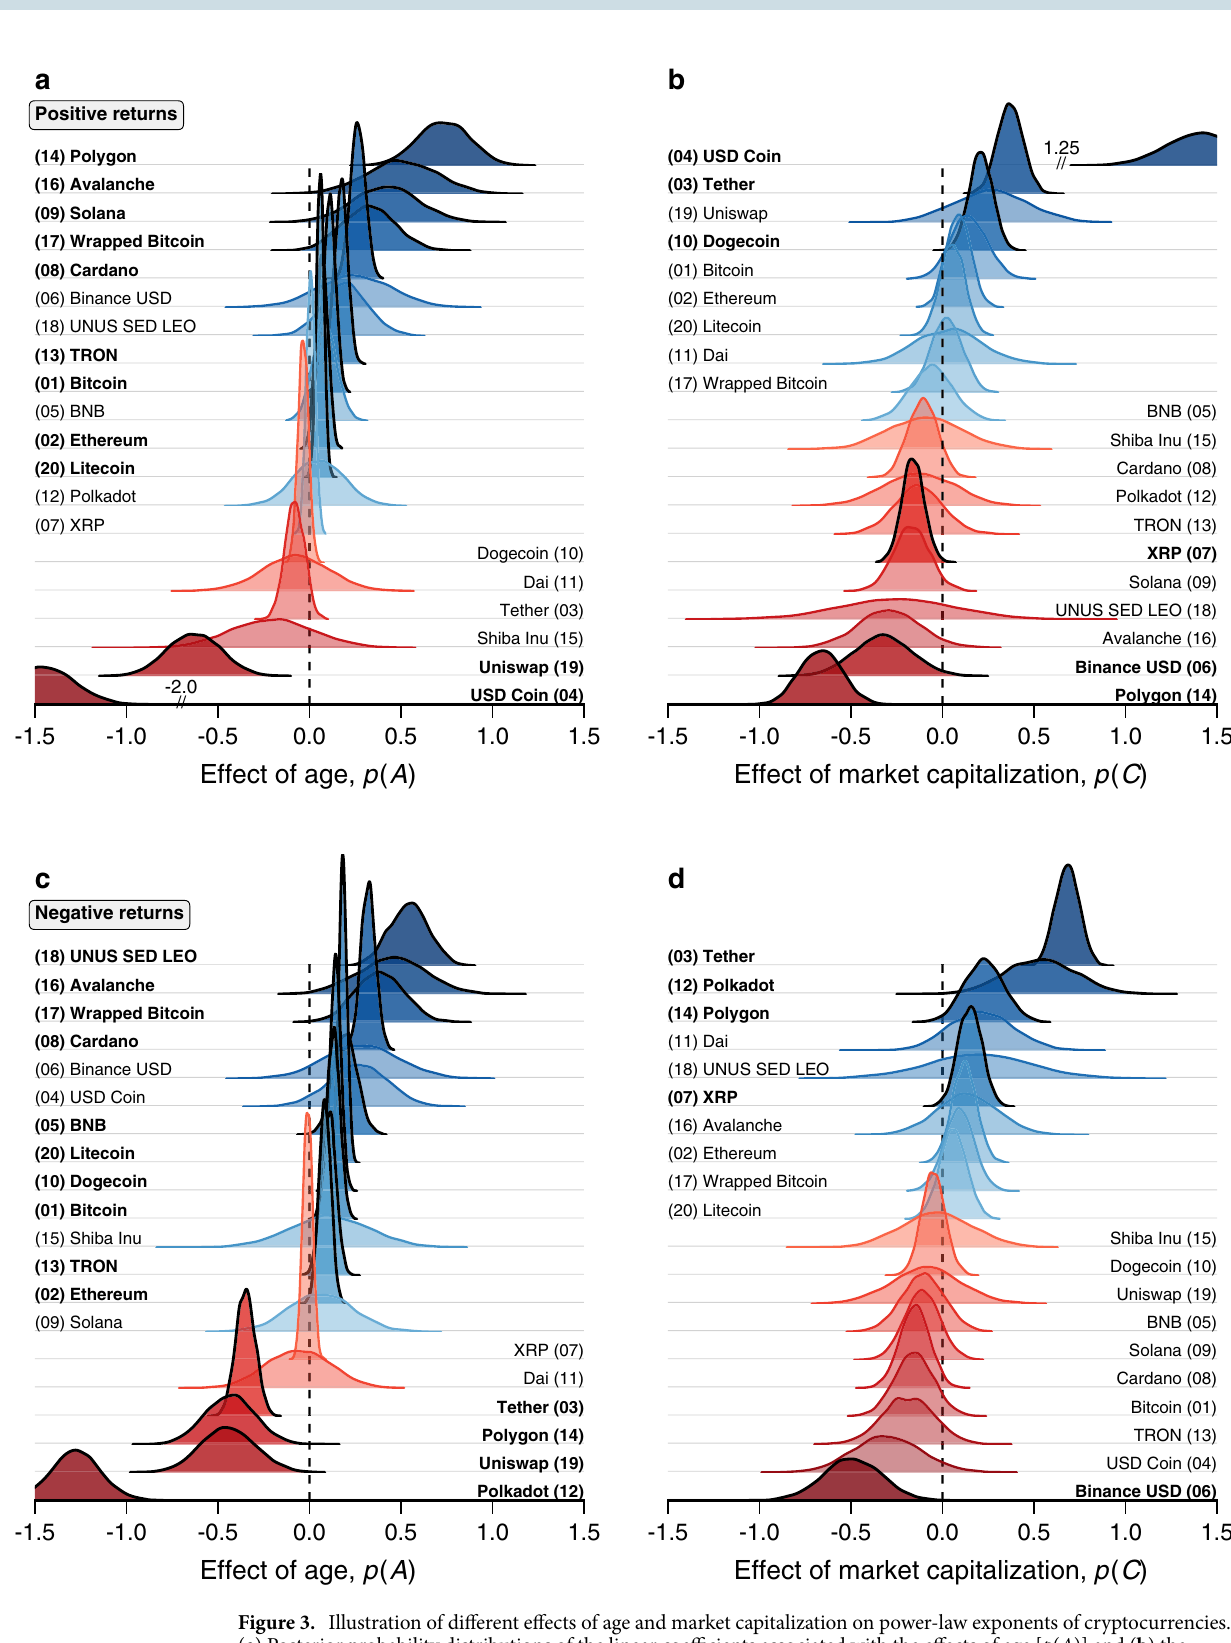
Figure 3. Illustration of different effects of age and market capitalization on power-law exponents of cryptocurrencies. ( a ) Posterior probability distributions of the linear coefficients associated with the effects of age [ p ( A )] and ( b ) the effects of market capitalization [ p ( C )] on power-law exponents related to large positive returns. Panels ( c ) and ( d ) show the analogous distributions for the association with power-law exponents related to large negative returns. In all panels, the different curves show the distributions for each of the top 20 cryptoassets by market capitalization. Cryptocurrencies significantly affected by age or market capitalization are highlighted in boldface, and the numbers between brackets show their positions in the market capitalization